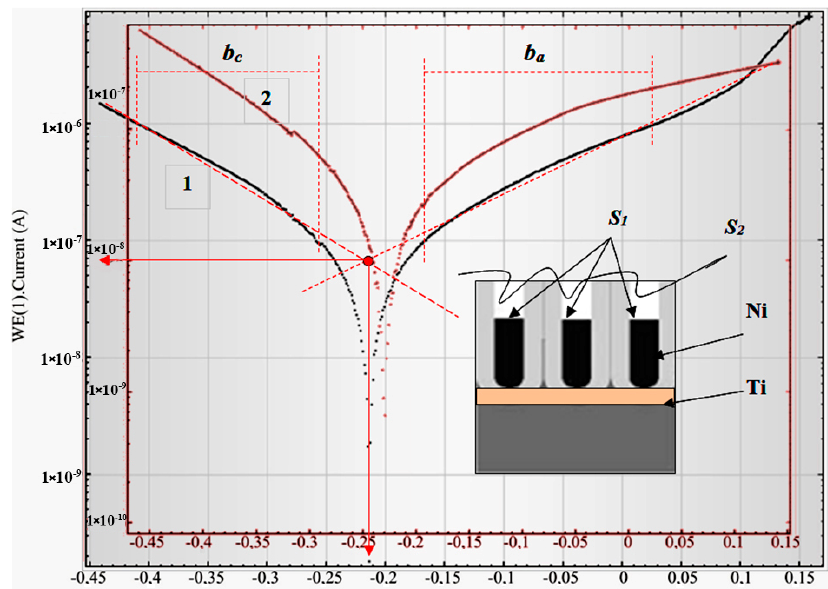
Figure 6. Linear sweep voltammograms of the Ti / PAAT / NiNPs sample in the 0.9% NaCl aqueous solution at a potential scanning rate of 0.1 V / s: 1—the fourth cycle of polarization, 2—the second cycle of polarization. Nanomaterials 2020 , 10 , 173